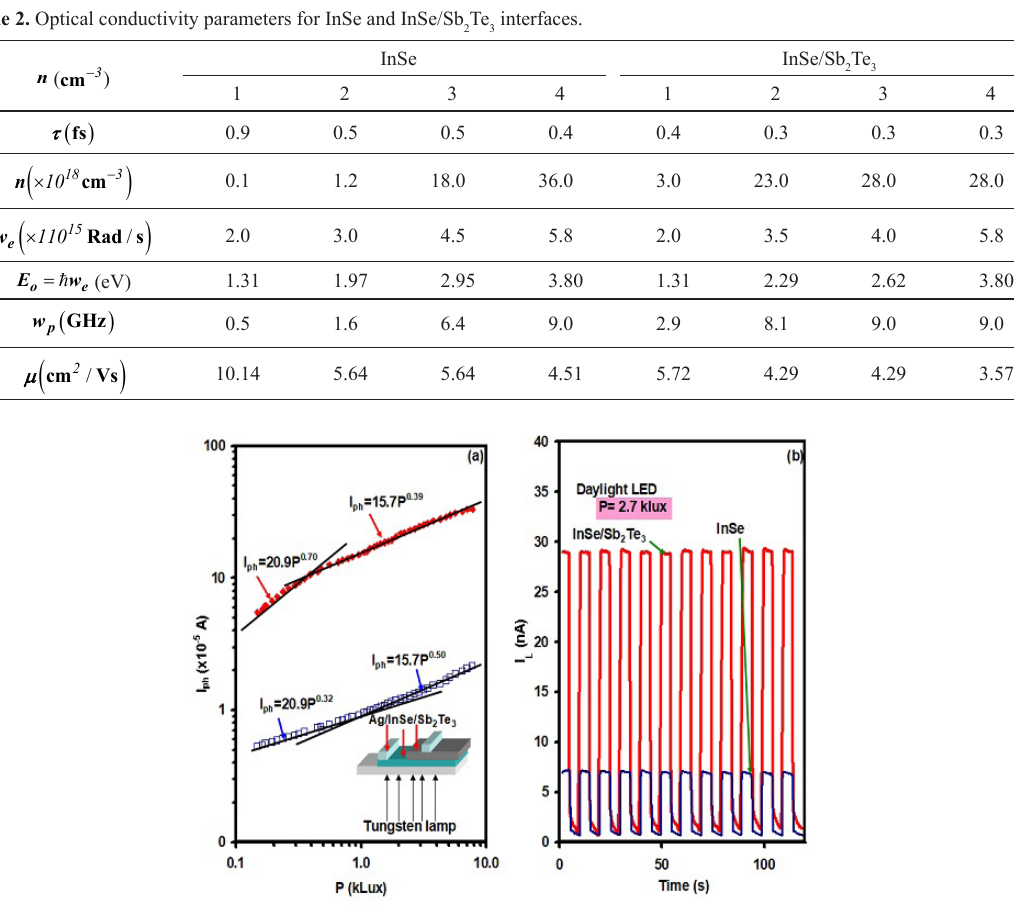
Figure 5. (a) the photocurrent-illumination intensity dependence and (b) the time dependent illuminated current for the planner Ag/InSe/ Sb Te /Ag heterojunction devices. The inset of (a) shows the schematics of the photo-sensing 2 3